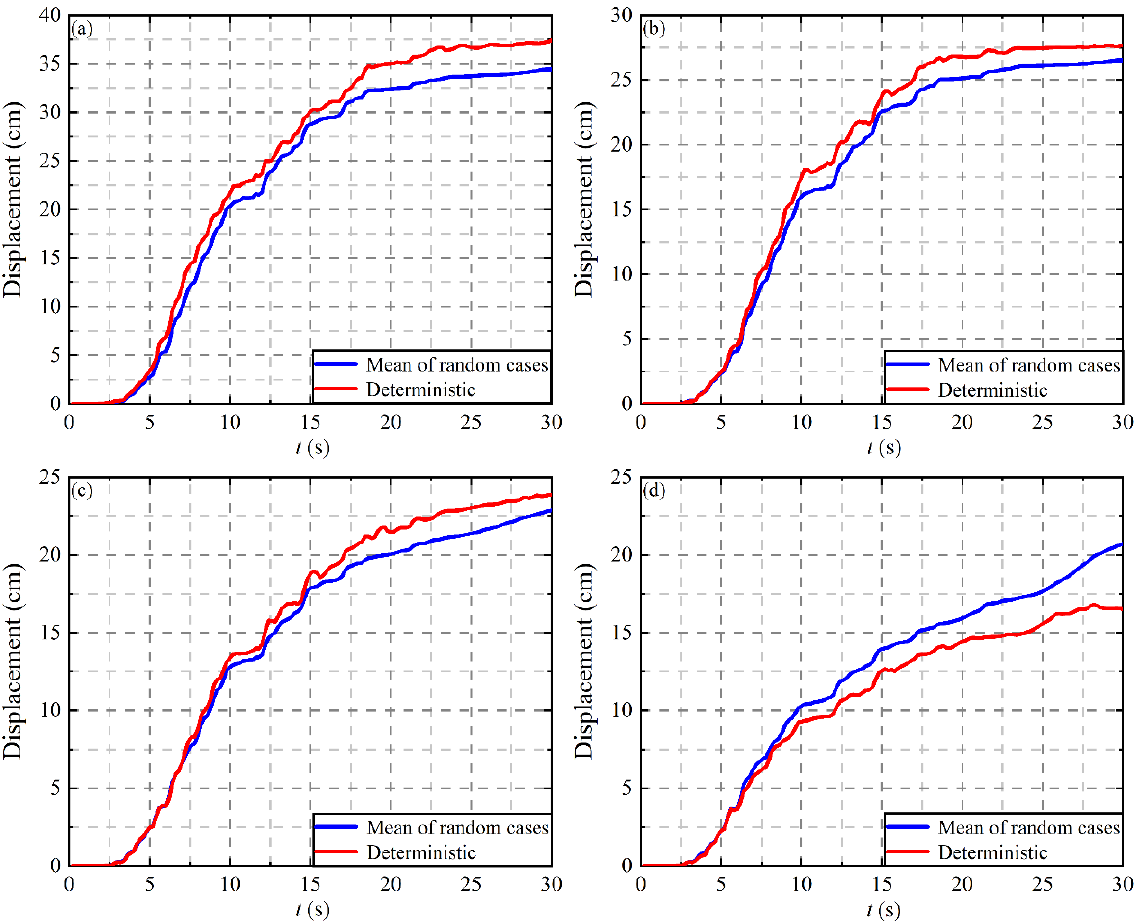
Figure 11. Comparison of time history curve of the uplift displacement of the tunnel under different embedment depths: ( a ) H = 6 m; ( b ) H = 8 m; ( c ) H = 10 m; ( d ) H = 12 m.